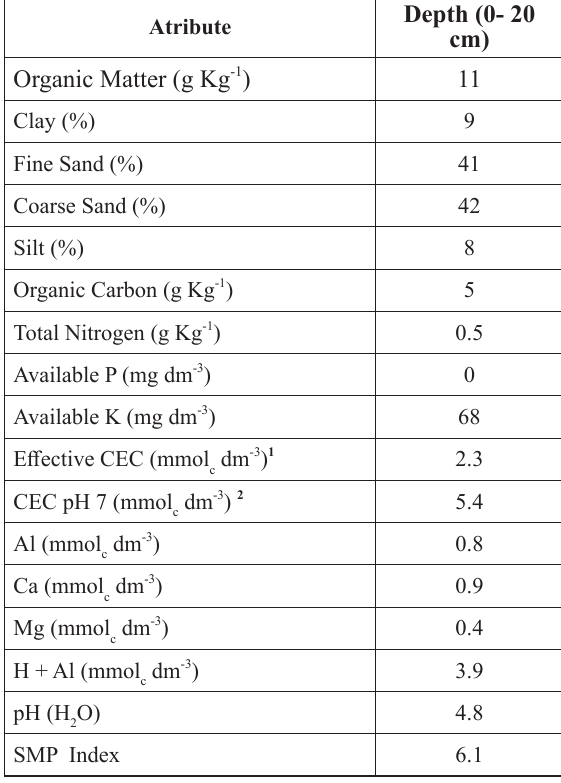
Physicochemical attributes of ultisol